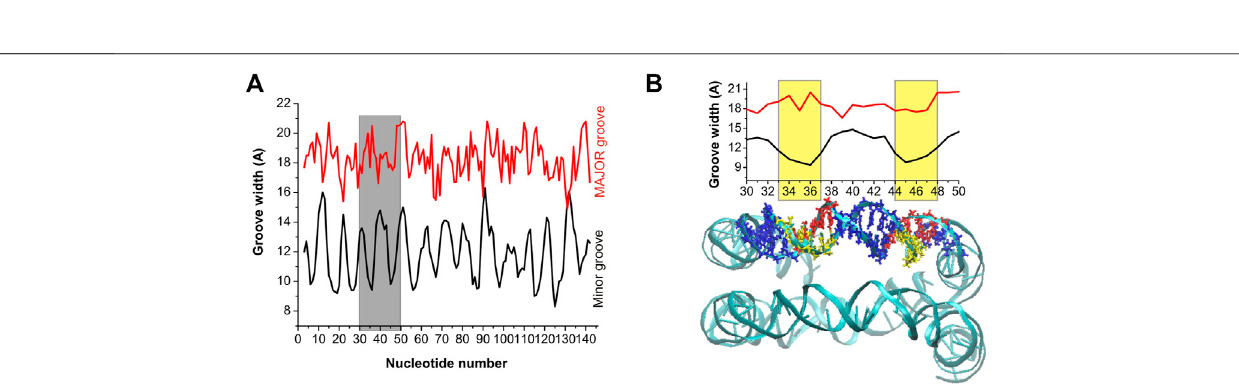
Frontiers in Chemistry |